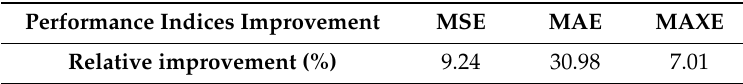
Table 10. Relative performance improvement of the SMO-based estimator over the phasor diagram based estimator during dynamic disturbances of active power for generator operating point P = 0.89, Q =